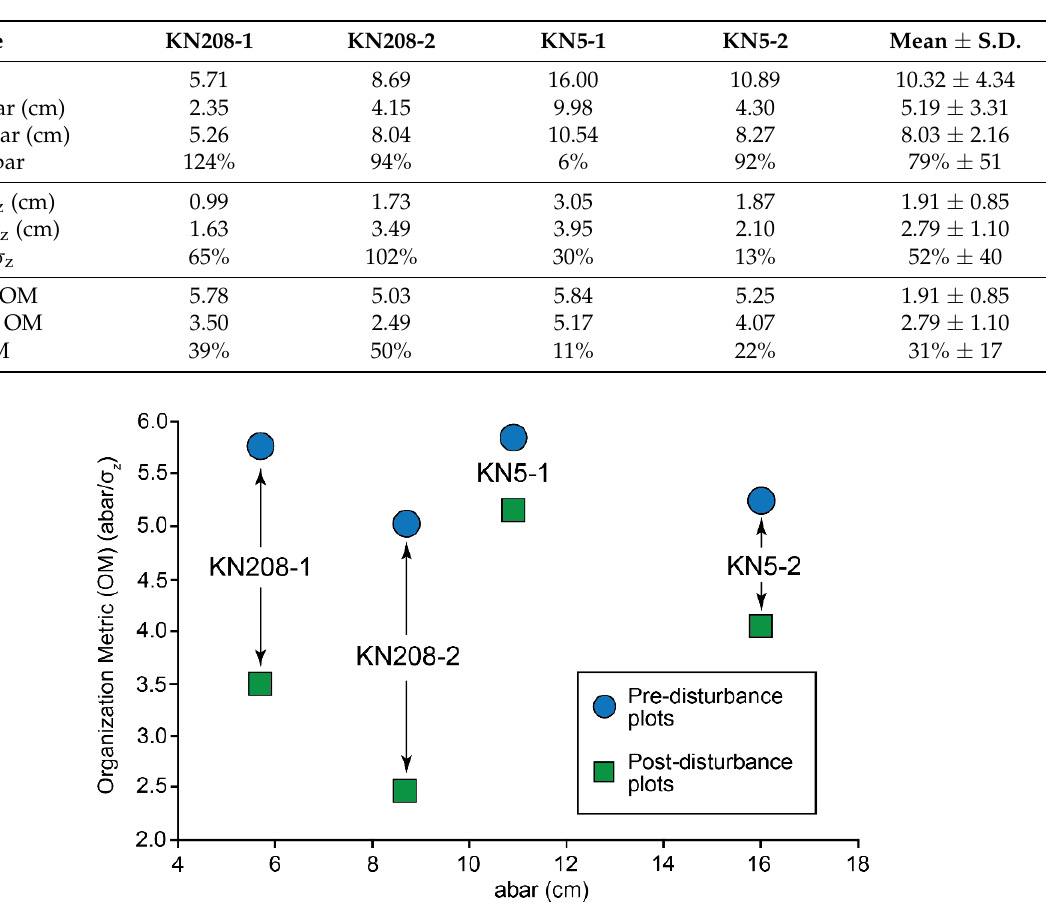
Table 5. Results of Validation Test #3: comparison of plots before and following manual physical disturbance.